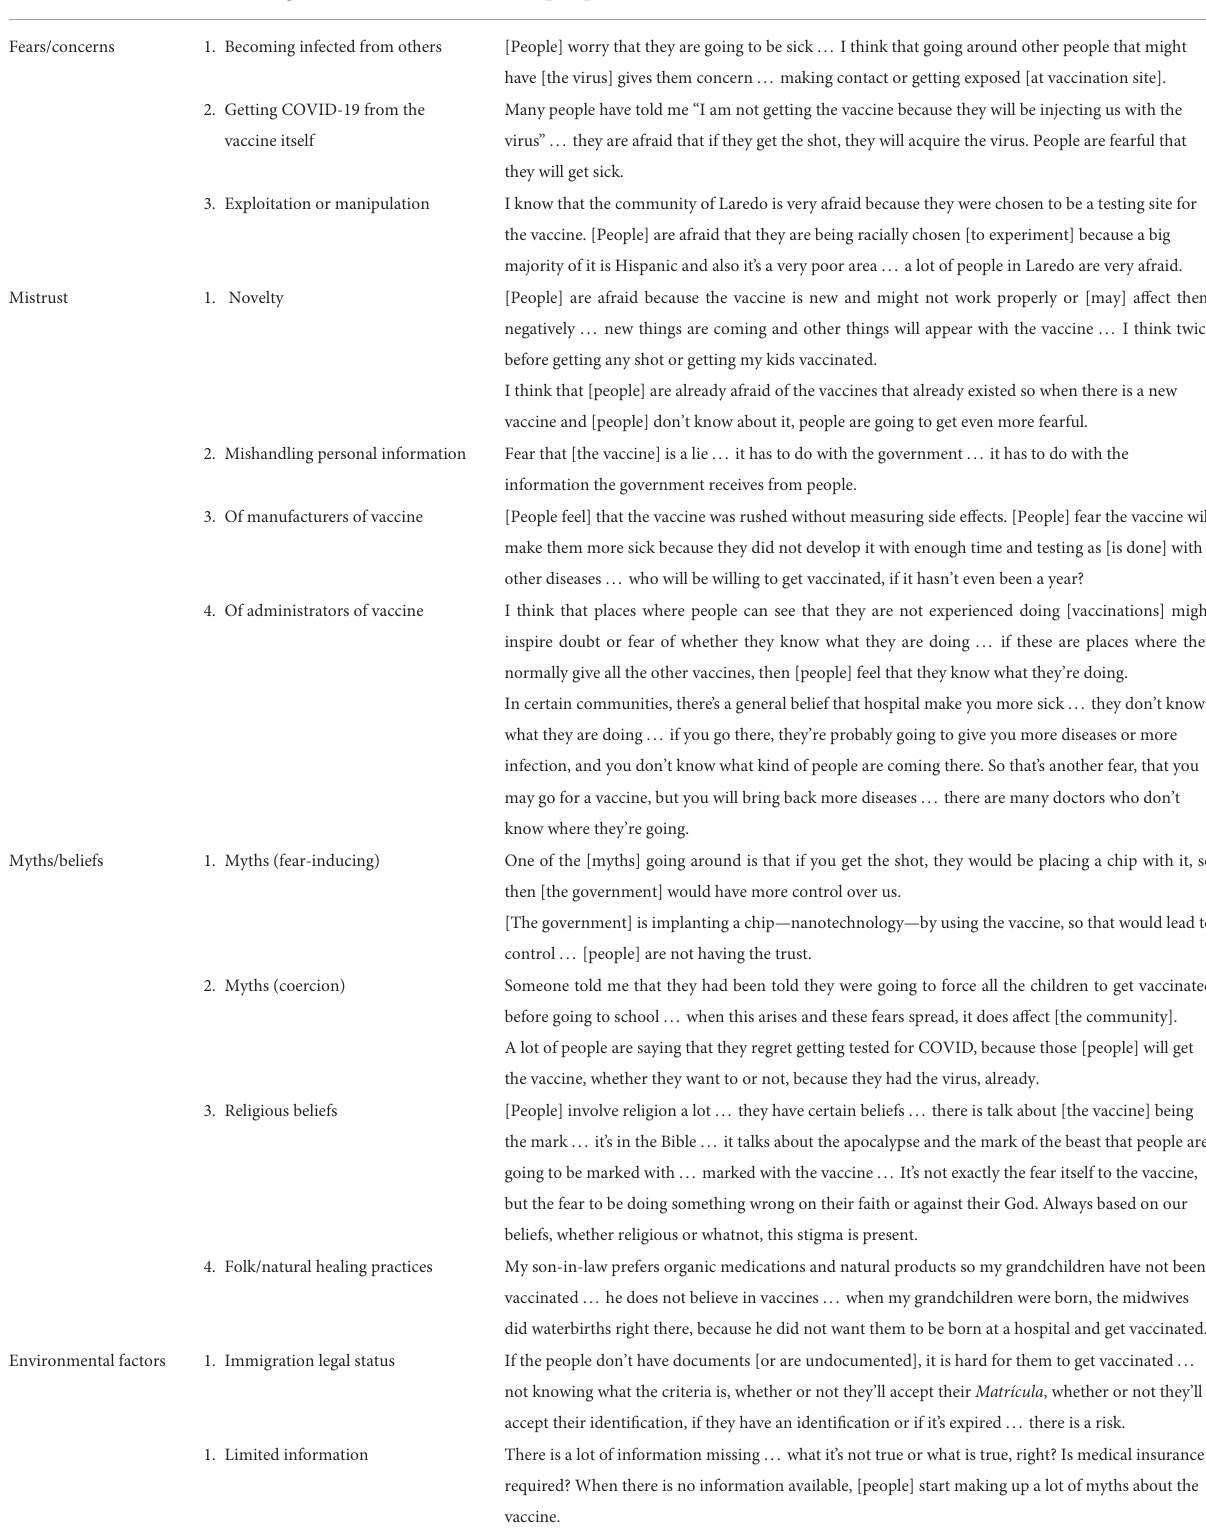
TABLE 2 Personal, environmental, and community barriers to vaccination for COVID-19 according to CHW/Ps.